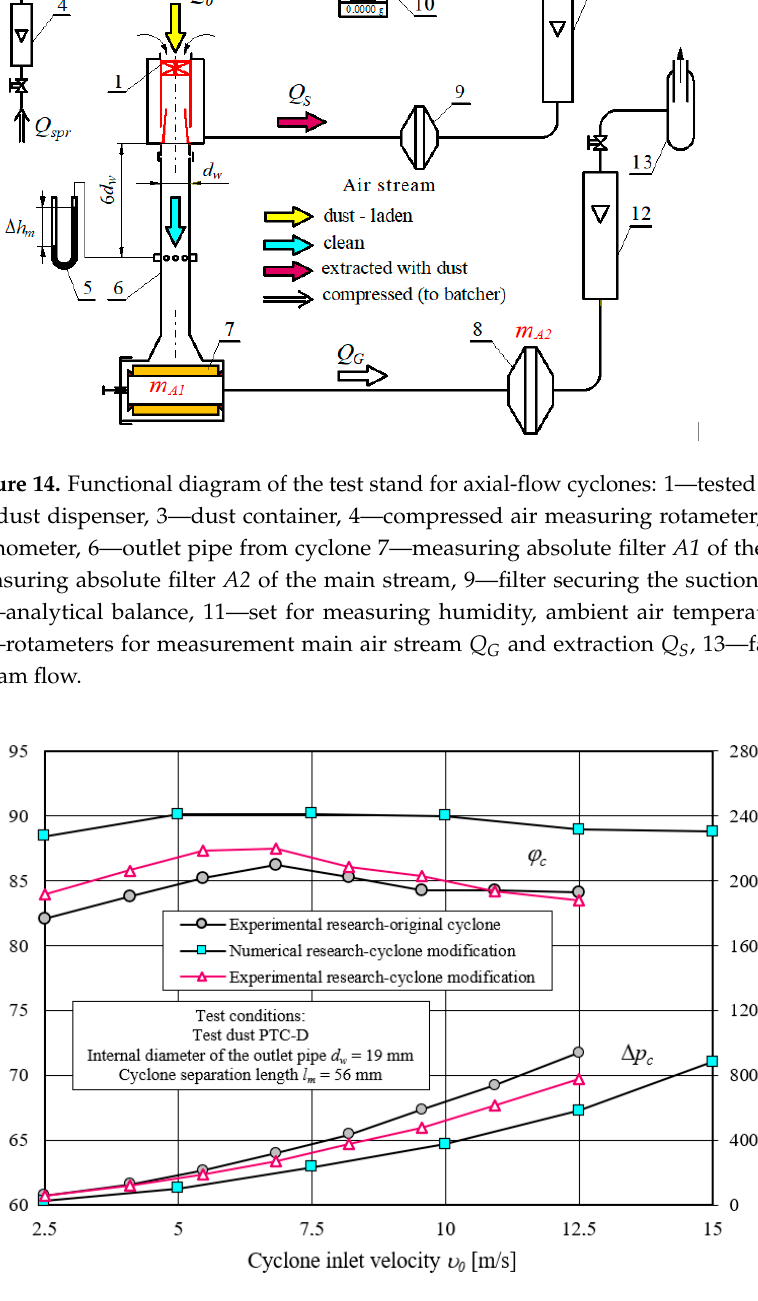
Figure 15. Numerical and experimental test results of cyclone separation efficiency depending on the inlet velocity υ 0 .